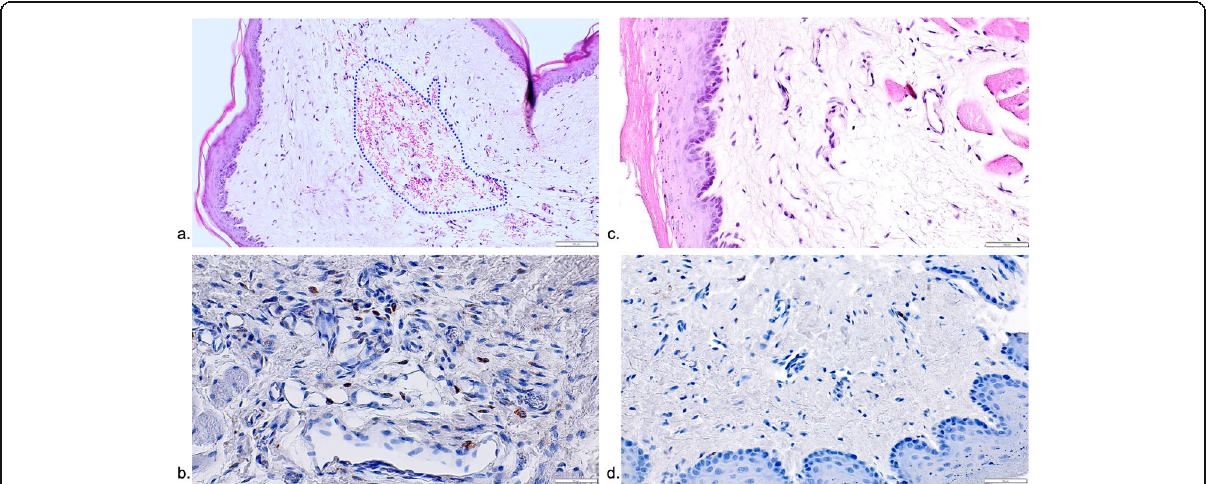
Fig. 4 Representative histological and immunohistochemical views of tissue reactions in the Be and Co groups. a The frequency and extend of ICTs in the Be group was commonly very low (HE stain). b Only a few connective tissue areas presented with CD68-positive cells (Be group). c Specimens of the Co group mainly featured a non-infiltrated connective tissue zone. d The frequency of CD68-positive cells was commonly low (Co